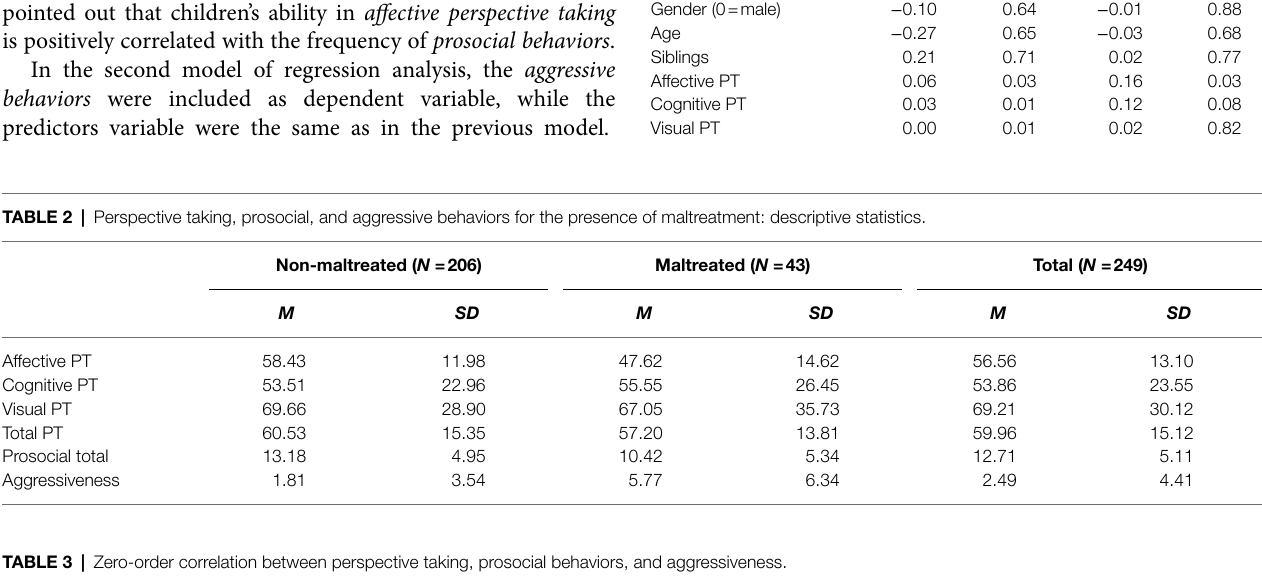
TABLE 3 | Zero-order correlation between perspective taking, prosocial behaviors, and aggressiveness. S. No. 1